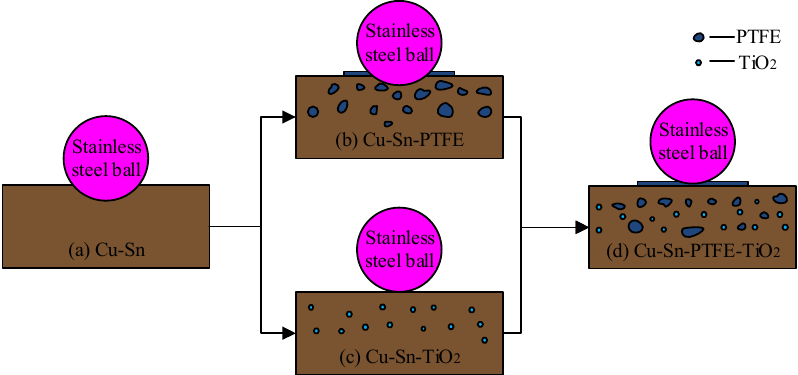
Figure 10. The schematic diagram of the friction mechanism of each Cu–Sn base coatings: ( a ) Cu–Sn; ( b ) Cu–Sn–PTFE; ( c ) Cu–Sn–TiO 2 ; ( d ) Cu–Sn–PTFE–TiO 2 .